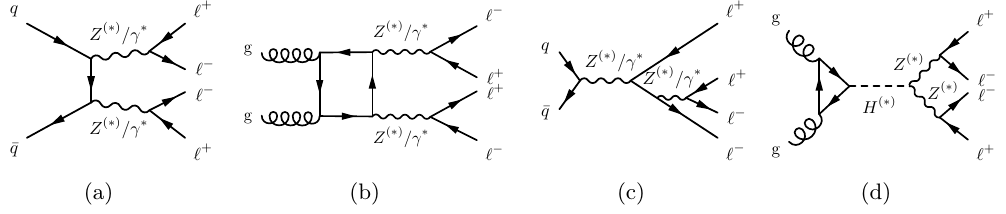
Figure 1 . Main contributions to the pp → 4 ‘ ( ‘ = e, µ ) process: (a) t -channel q ¯ q → 4 ‘ production, (b) gluon-induced gg → 4 ‘ production via a quark loop, (c) internal conversion in Z boson decays and (d) Higgs-boson-mediated s -channel production (here: gluon-gluon fusion). The superscript ( ∗ ) refers to a particle that can be either on-shell or off-shell, whereas ∗ indicates that it is always